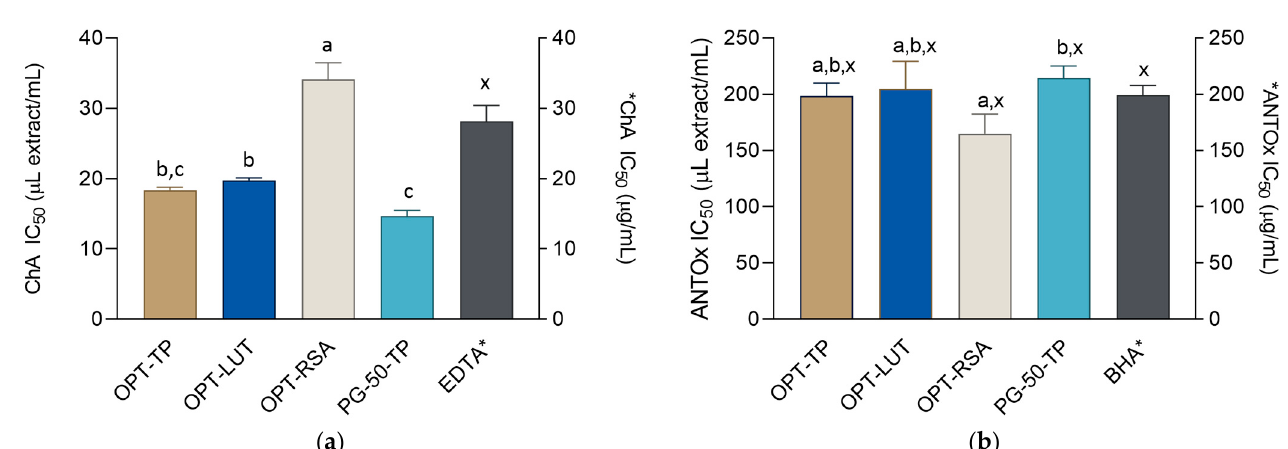
Figure 2. Antioxidant activity of the extracts and positive controls EDTA (ethylenediaminetetraacetic acid) and BHA (butylated hydroxyanisole) in: ( a ) chelating activity (ChA) and ( b ) β -carotene-linoleate assay. The activities are shown as IC 50 values ± SD. a–c = differences between the extracts within a column (Tukey post-test, p < 0.05). x = differences with the positive control (Dunnett’s post-test, p < 0.05). Columns not connected with the same letter are statistically different. Asterisk indicates that the unit is placed at the right ordinate.